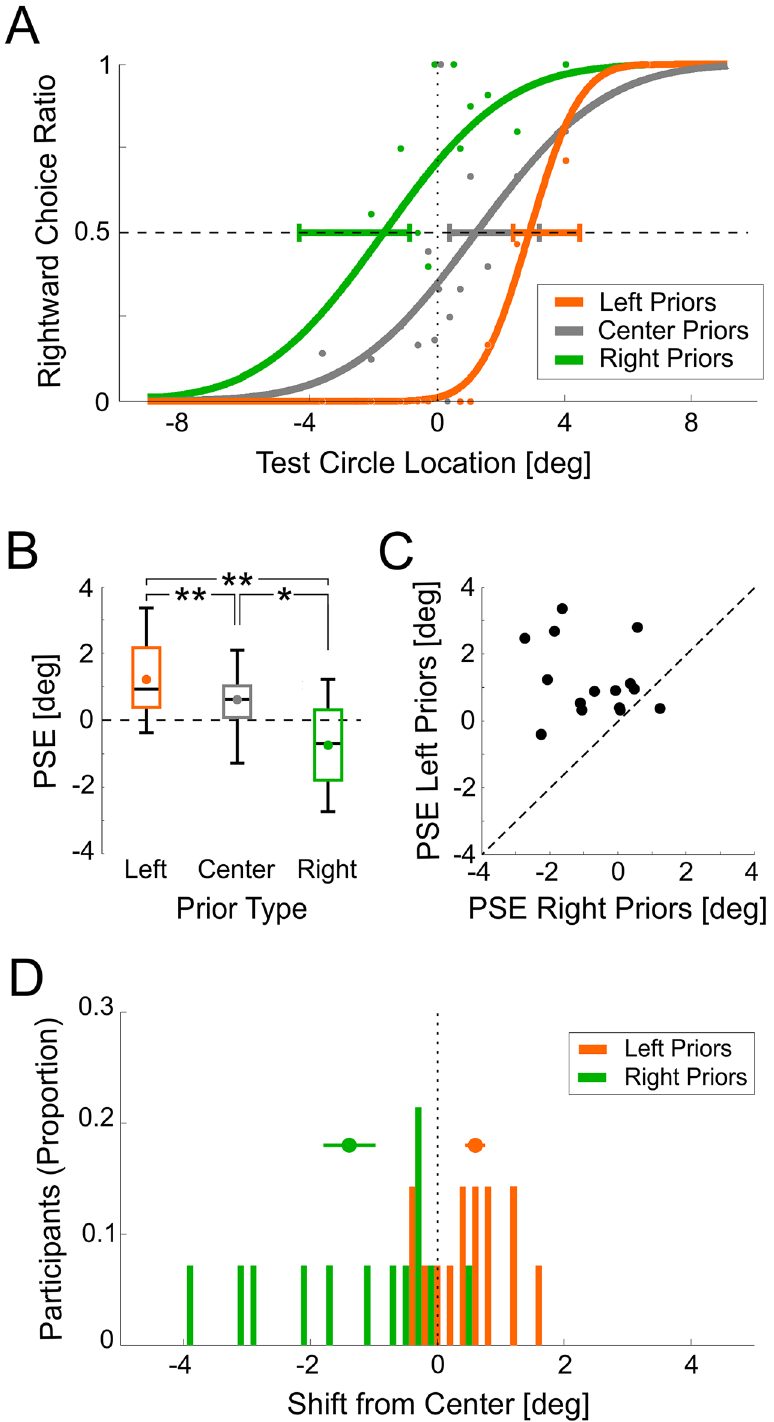
Figure 3. Baseline (Condition #1A) results. ( A ) Psychometric functions are presented for an example participant, sorted by prior type: left, center and right (orange, gray and green, respectively). The data points represent the proportion of rightward choices (for the test circles only) fitted (per prior type) with a cumulative Gaussian distribution function (solid lines). The horizontal dashed line marks the point of subjective equality (PSE; y = 0.5), and the vertical dotted line marks the screen center (x = 0). Horizontal error bars mark 95% confidence intervals of the PSE. ( B ) Summarized PSEs of the group data for the three prior types: left, center and right (orange, gray and green, respectively). The median and range of the data are represented by the black lines and whiskers, respectively. The colored dots represent the respective means. ( C ) PSEs for left vs. right prior types. Each data point represents one participant. The diagonal line marks y = x. ( D ) Distribution of PSE shifts across participants, calculated by subtracting the unbiased (center) PSE from the left and right prior type PSEs (orange and green, respectively). The objective screen center (x = 0) is represented by the vertical black dotted line. Above the histograms, mean ± SEM are presented by the circle markers and horizontal lines, respectively. * p < 0.05, ** p ≤